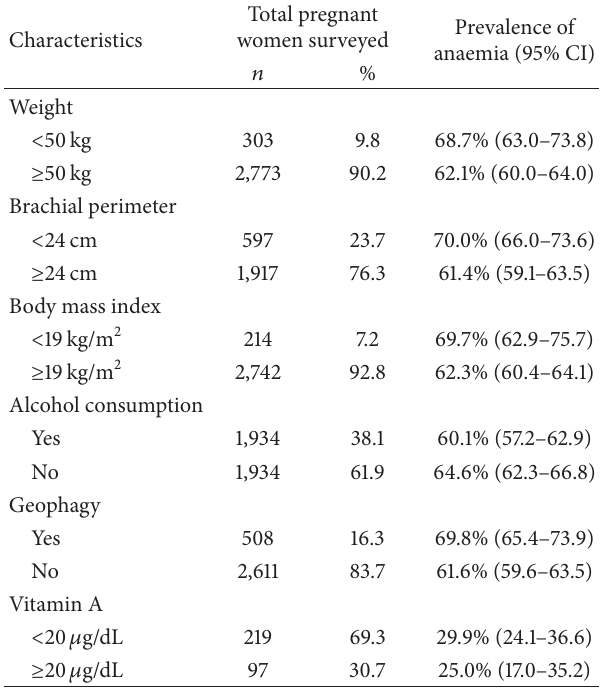
Figure 1: Distribution of types ∗ of maternal anaemia in Hound´e health district, Burkina Faso. Table 1: Nutritional status of pregnant women in Hound´e health district, Burkina